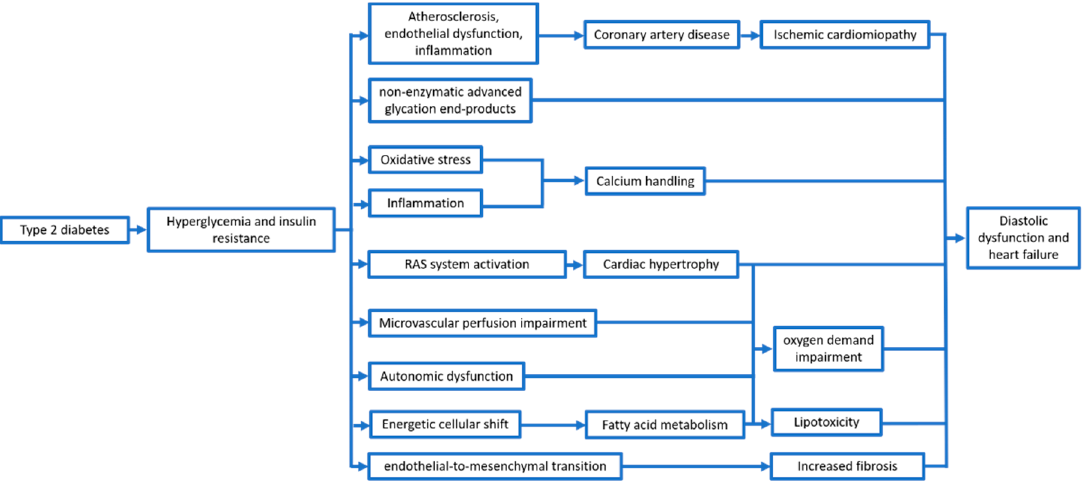
Figure 1. Main mechanisms leading to ventricular dysfunction in type 2 diabetes patients.